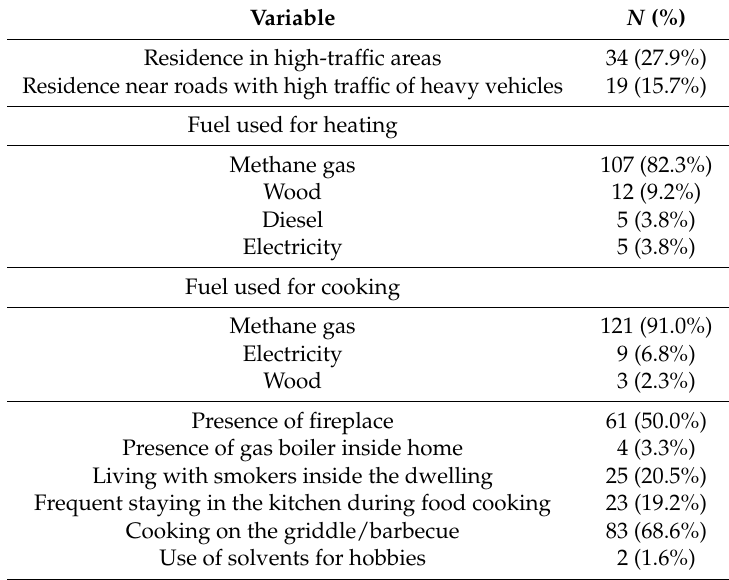
Table 4. Prevalence of exposure factors linked to the home context among the children participating in the IMP.AIR